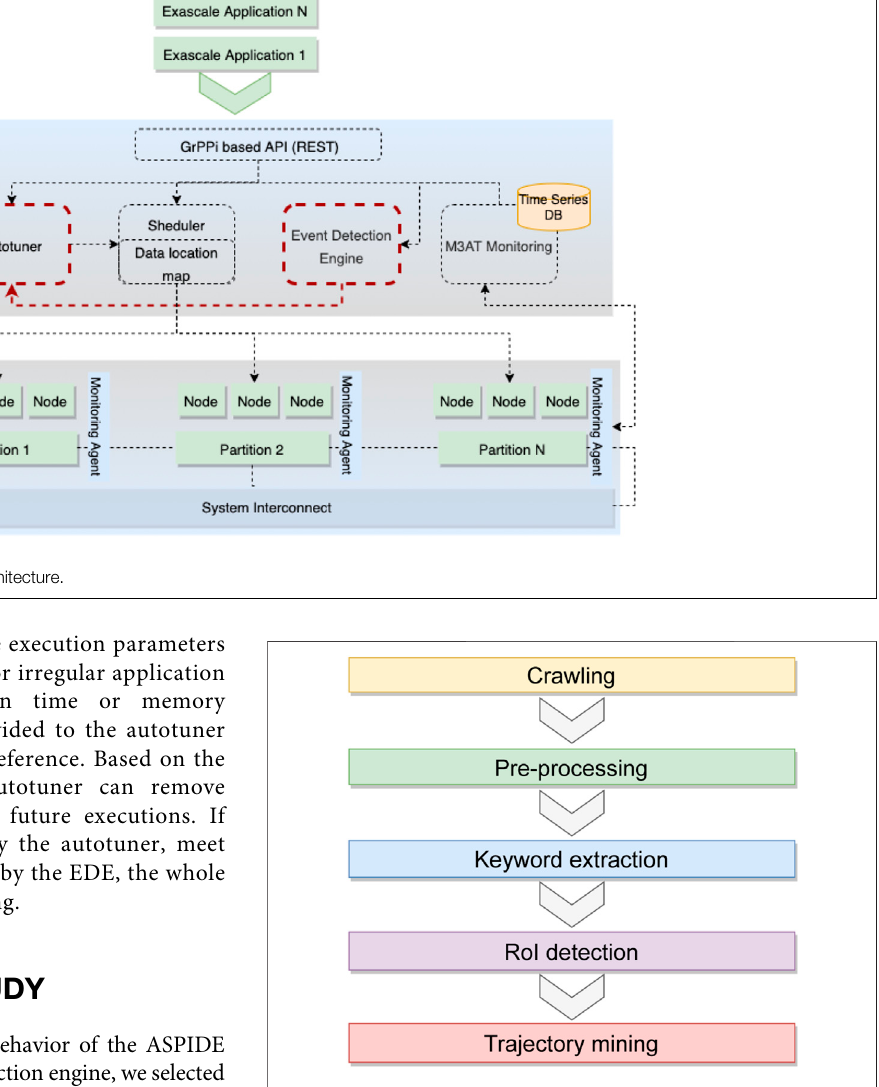
FIGURE 5 | Work fl ow of the urban computing use case